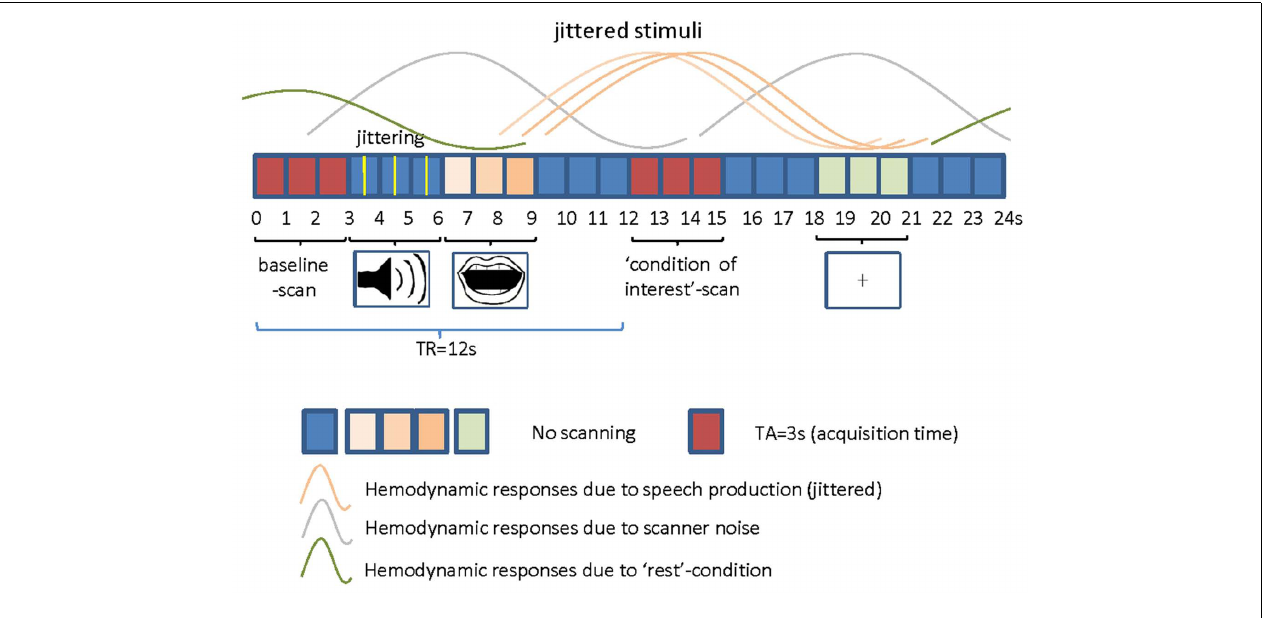
baseline/rest condition.The condition of interest (auditory presented sentences) was jittered at three different possible time points (3.5/4.5/5.5s), see the yellow vertical lines in blue colored boxes. Different hemodynamic responses to the different events occurring during task are indicated by colored waves above the time line.Waves in yellowish colors denote hemodynamic responses due to speech production (condition of interest, jittered); wave in gray color denotes responses due to scanner noise and wave in green denotes hemodynamic responses due to “rest”